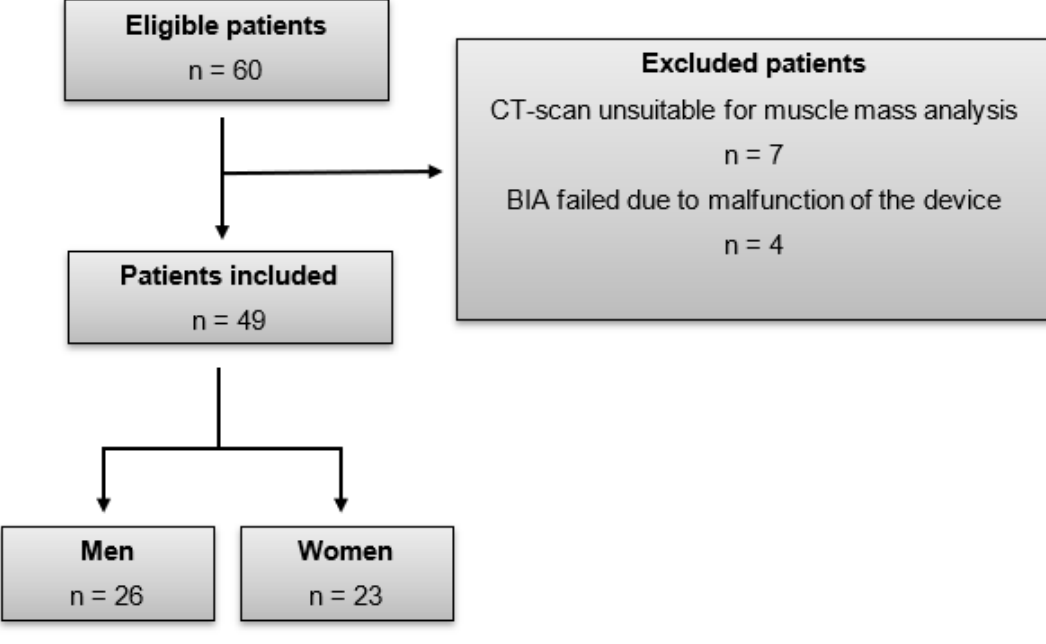
Figure 1. Flow chart of inclusion process.